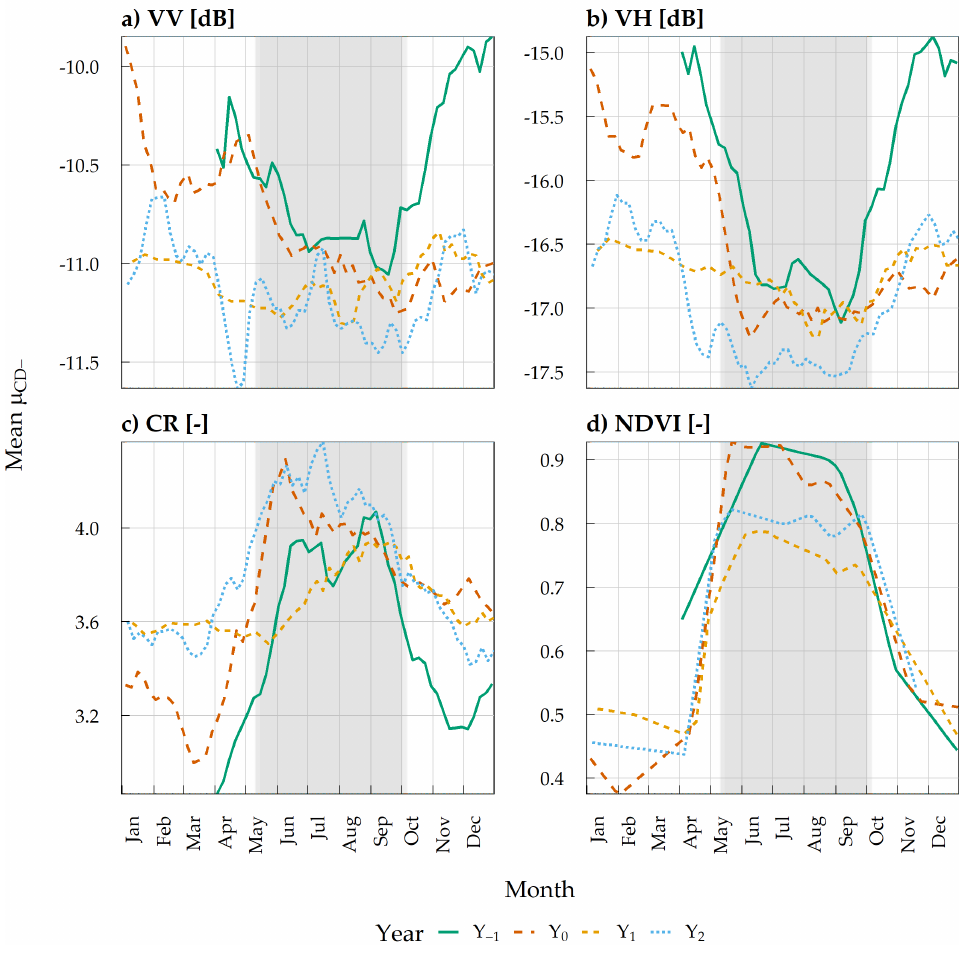
Figure 7. Sentinel-1 backscatter ( γ 0 and γ 0 ), the cross-ratio (CR) and Sentinel-2 NDVI data time VV VH series with ENL = 13. Averages of CD − class for Y − 1 – Y 2 (2017–2020). Grey lines delineate average phenological boundaries of spring and fall, which approximately coincides with leaf flush and fall, verified by non-drought S-2 NDVI in Y − 1